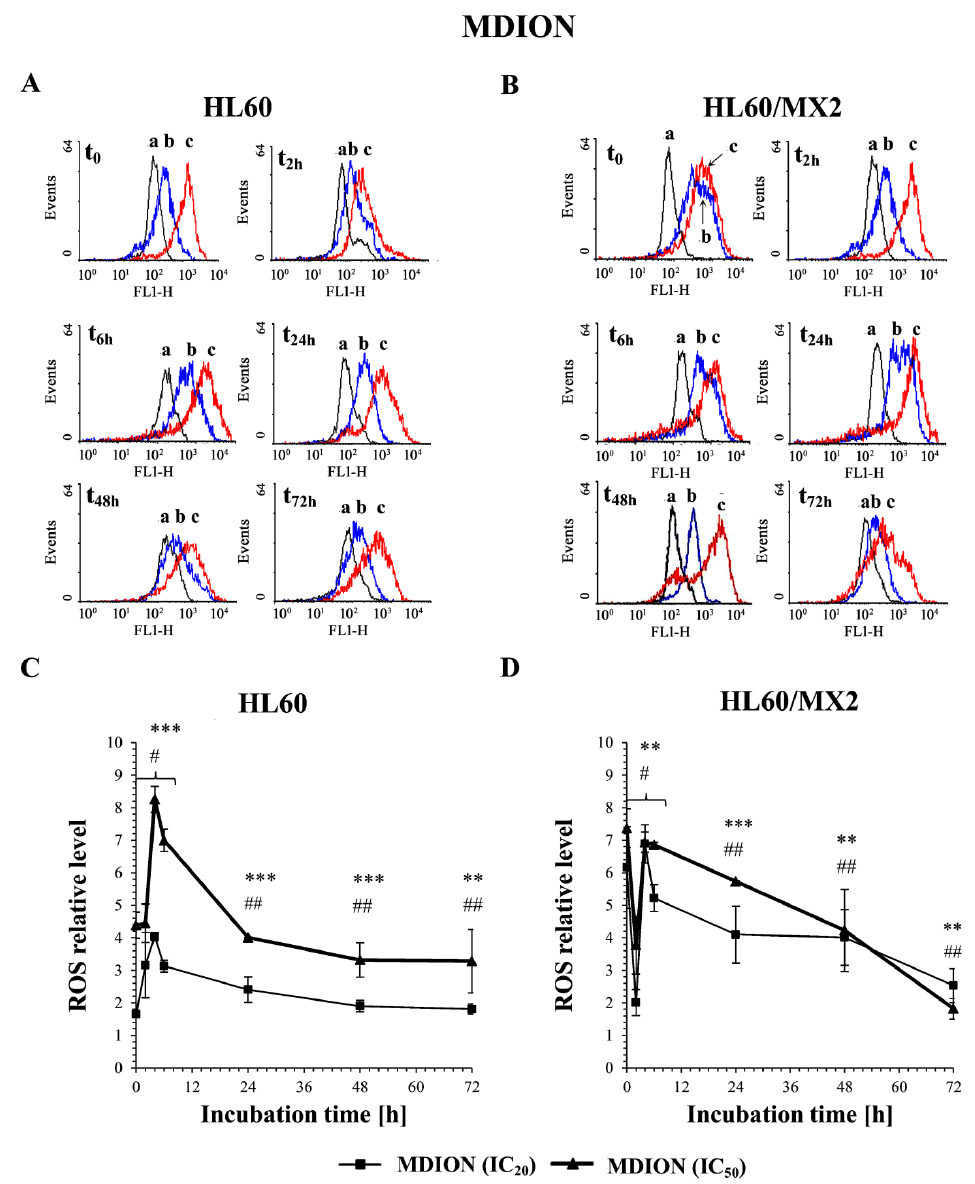
Figure 3. The effect of MDION on the reactive oxygen species (ROS) level in sensitive HL60 ( A , C ) and resistant HL60/MX2 ( B , D ) leukaemia cells. The cells were incubated at 37°C with MDION used at IC 20 (15.0 µM for HL60 cells and 17.0 µM for HL60/MX2 cells) or at IC 50 (80.5 µM for HL60 cells